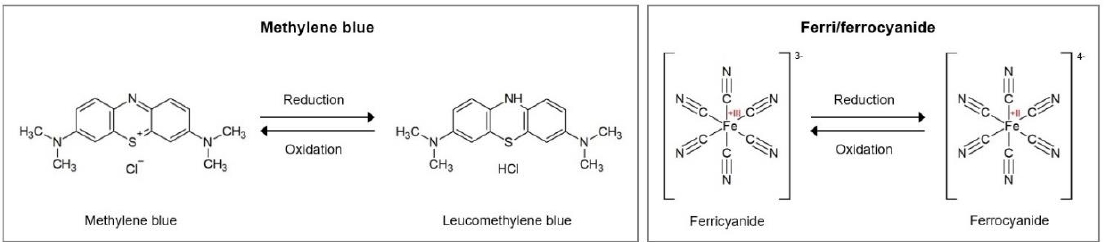
Figure 1. Reduction and oxidation of methylene blue and ferri/ferrocyanide as soluble redox mediators, figures based on the research paper